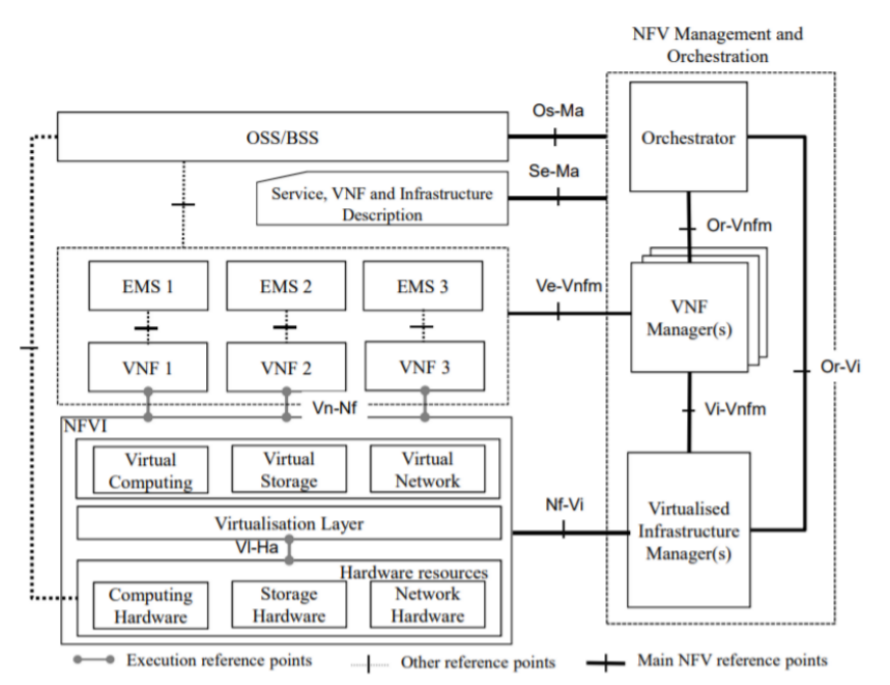
Figure 2. ETSI NFV reference architectural